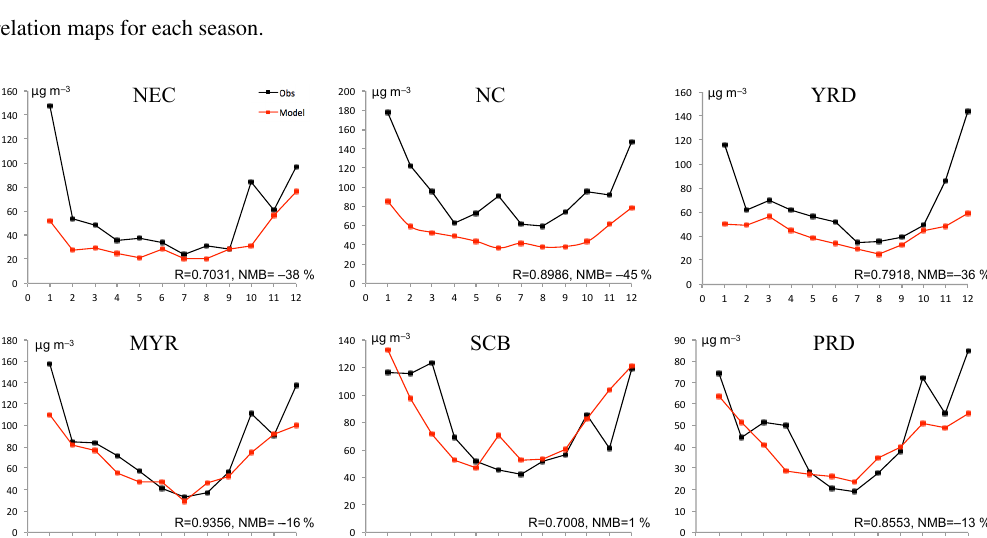
and the correlation coefficient varies between 0.7 and